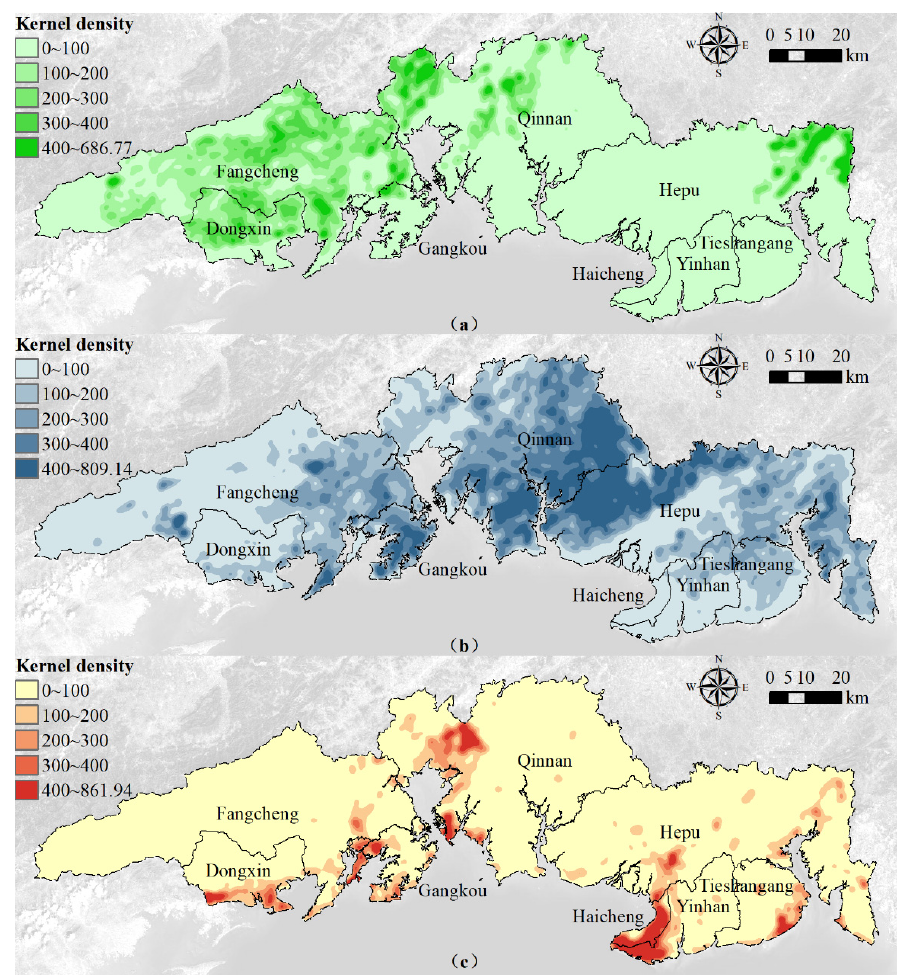
Figure 3. Kernel density analysis of increased forestland ( a ), increased orchard ( b ), and increased construction land ( c ) in the study area from 1999 to 2014. construction land ( c ) in the study area from 1999 to